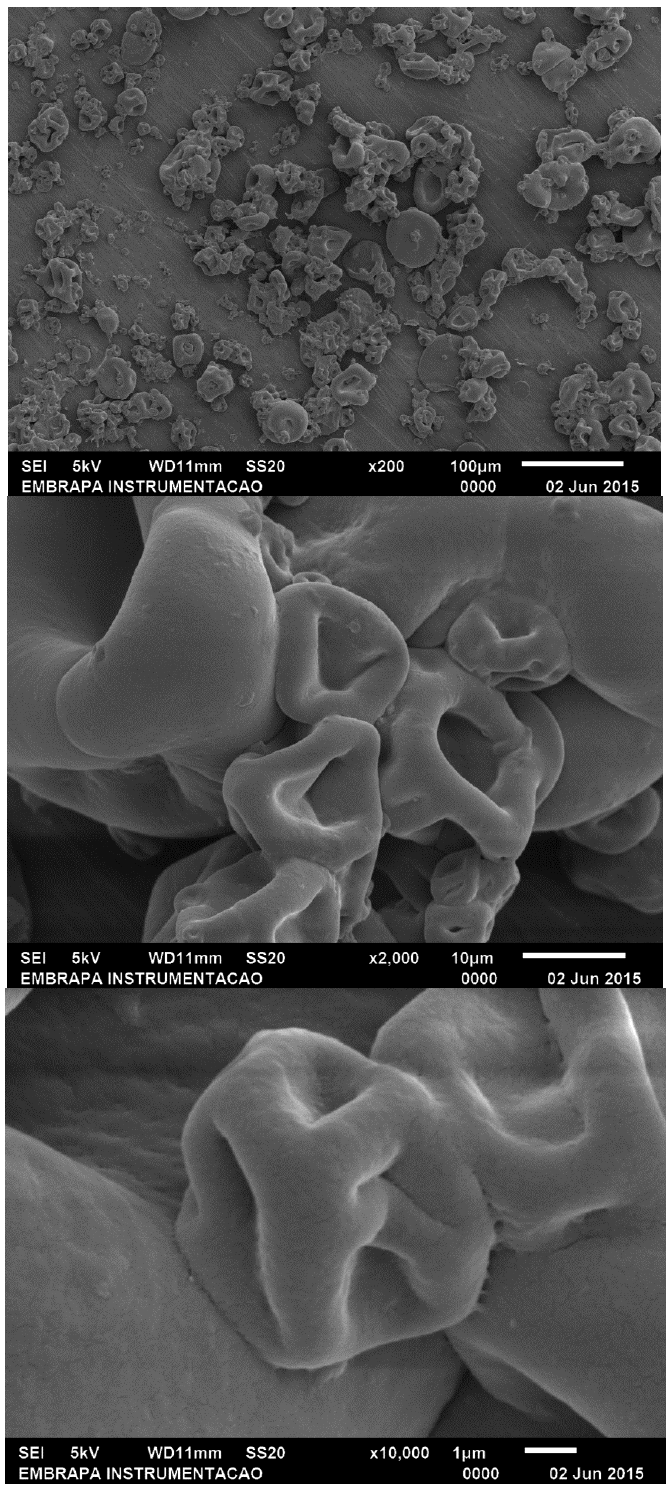
Figure 1. Images of CLEA-β-SPI-12 using scanning electron microscopy at different amplifications.